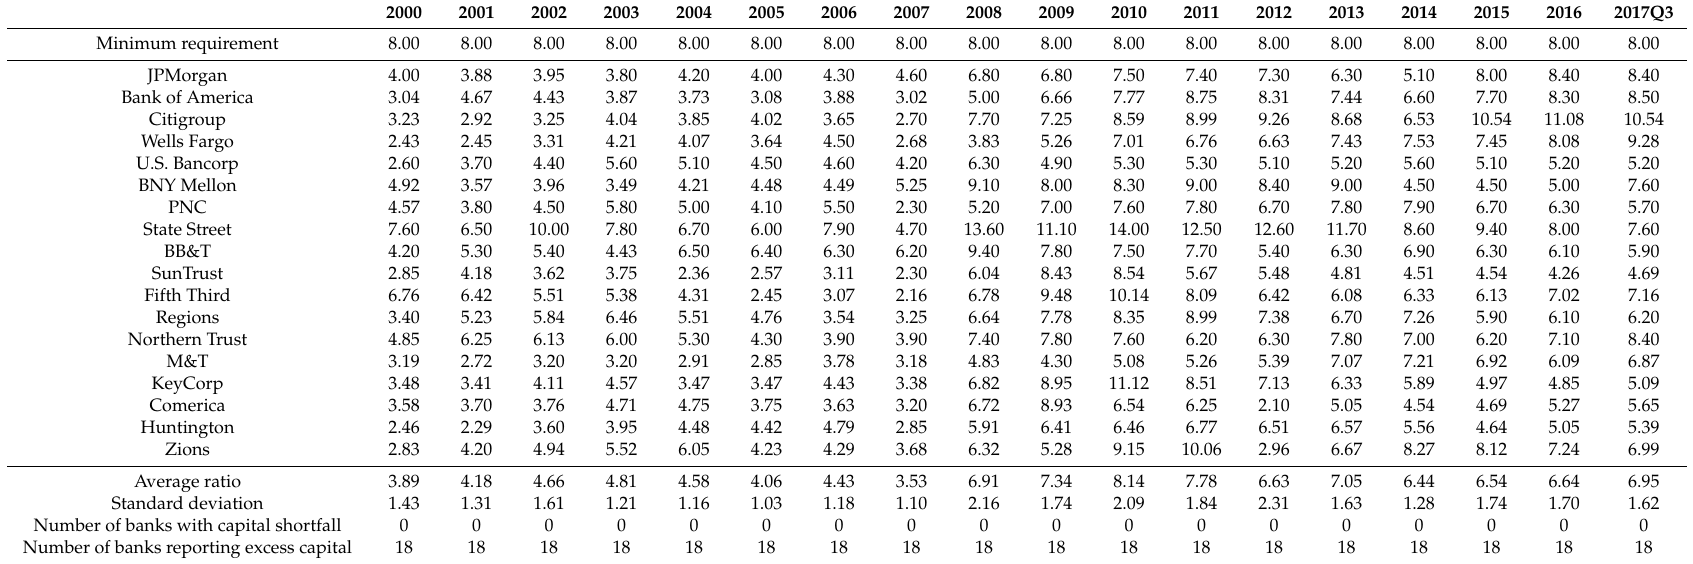
Table A2. Actual Total Capital Ratio Minus Required Minimum Total Capital Ratio of 8